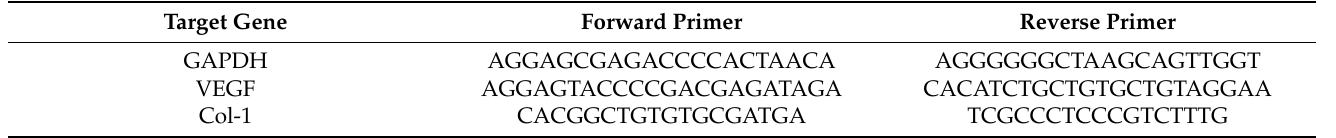
Table 1. Primers’ sequences used in this study.